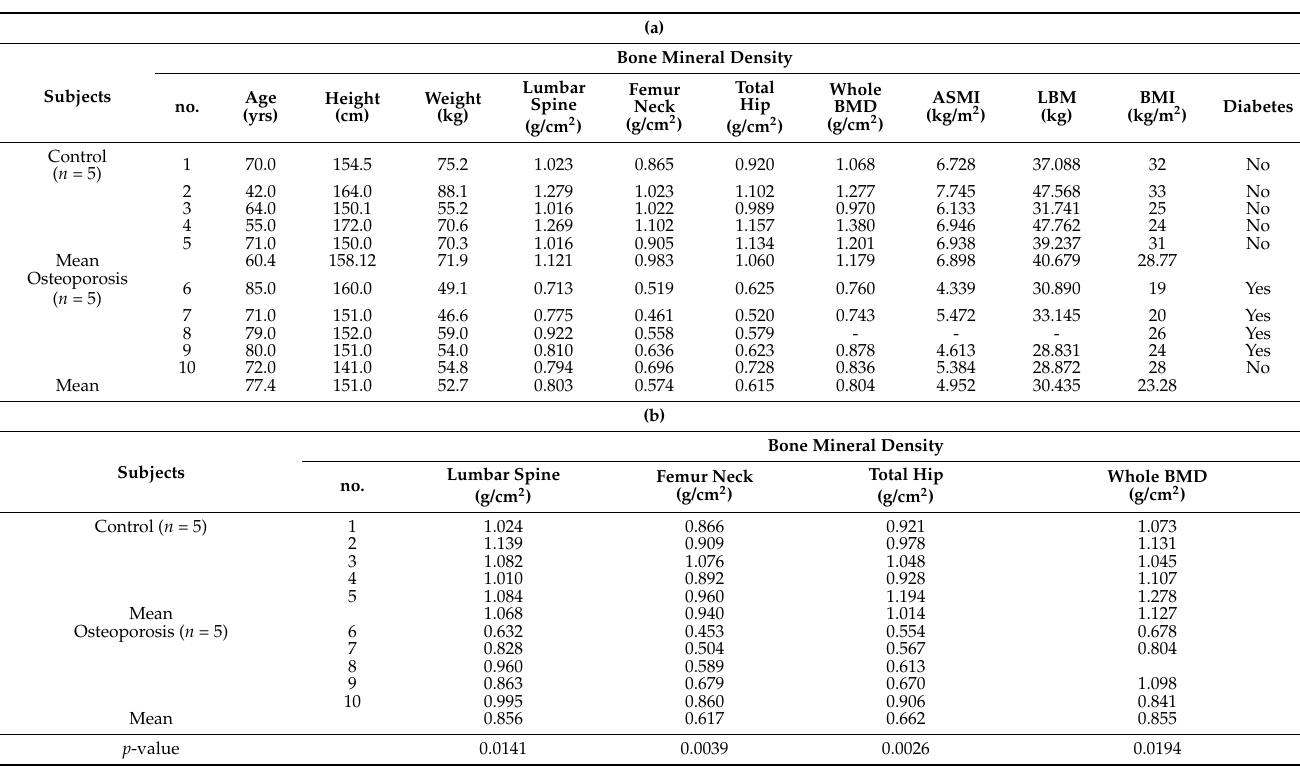
Table 1. ( a ) Clinical characteristics of study participants. ( b ) Age-adjusted analysis of bone min- eral